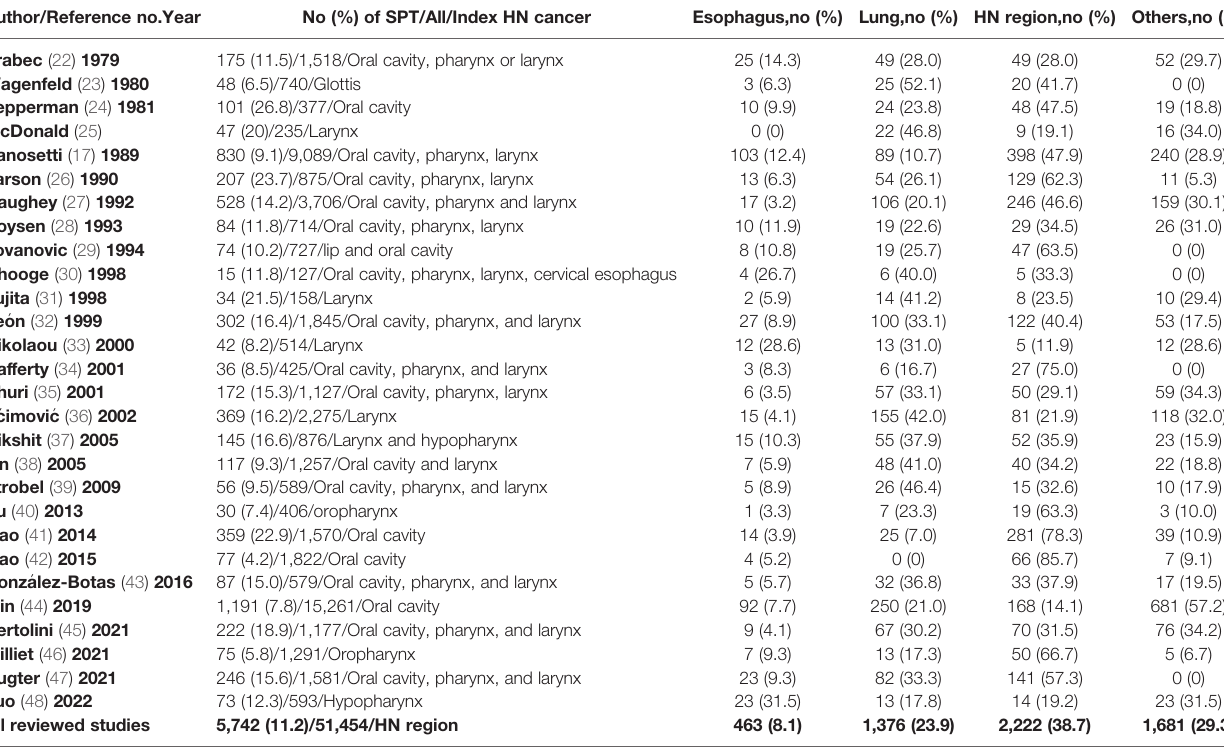
Frontiers in Oncology |